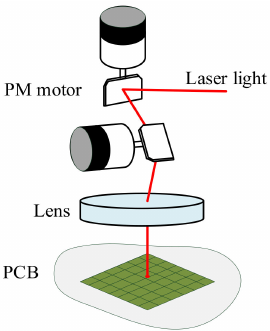
Figure 1. PM motor for PCB hole digging